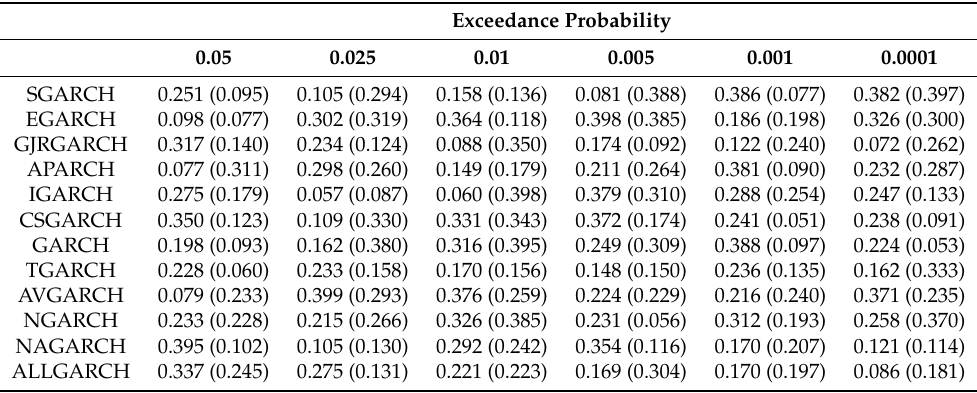
Table 7. p -values of the unconditional (conditional) coverage value at risk exceedance test for the log returns of the exchange rates of Monero from 22 June 2014–17 May 2017.